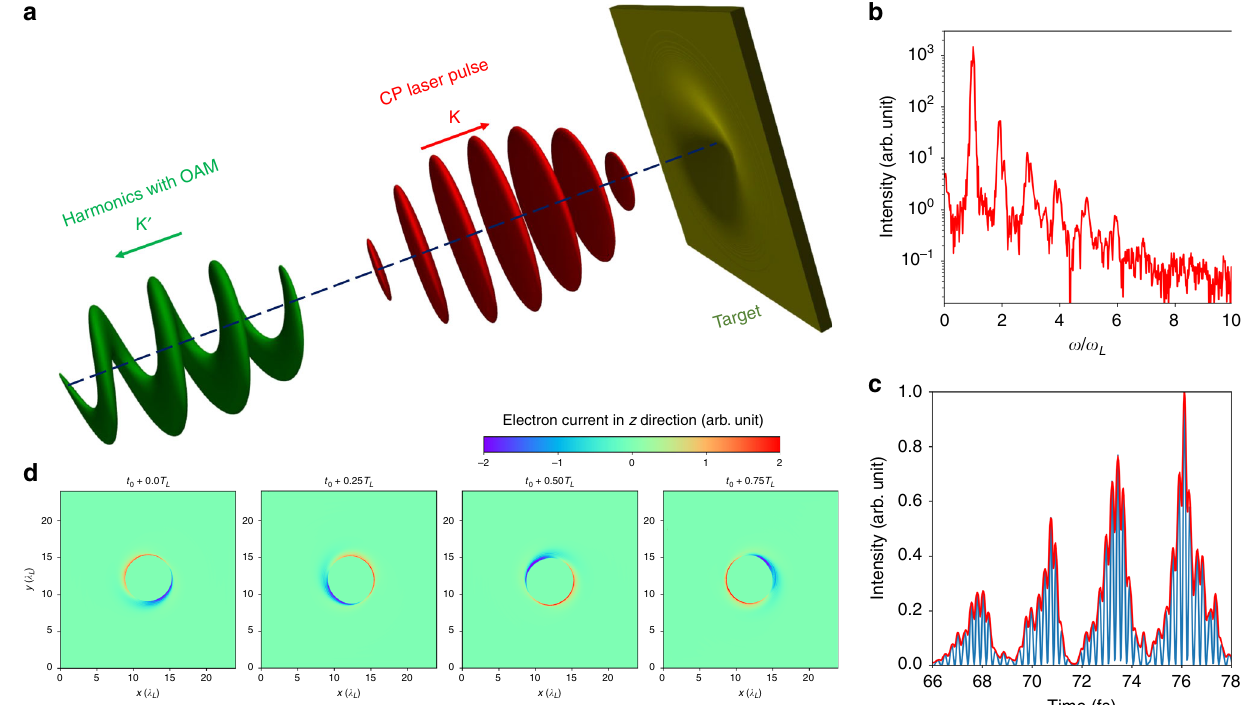
Fig. 1 OAM harmonics generation from a self-dented target. a A circularly polarized Gaussian laser pulse (red) is normally incident on an initially plane target. Note that a normally incident CP Gaussian pulse does not result in harmonic generation on a plane target. However, Gaussian laser pulses deform the target by the radiation pressure of the laser pulse, resulting in electric- fi eld component normal to off-axis laser fi eld obliquely incident. The deformed target then transfers the spin angular momentum of the driving laser (red) to the orbital angular momentums of the re fl ected harmonics (green). b Spectrum of the off-axis re fl ected electric fi eld. The frequency is normalized by the laser angular frequency ω pulse train after fi ltering out low order ( n (cid:4) 4) harmonics. d Transverse distributions of the electron current in the z direction at a fi xed z ¼ 6 : 4 λ different times. The setup of the target can be found in the Methods